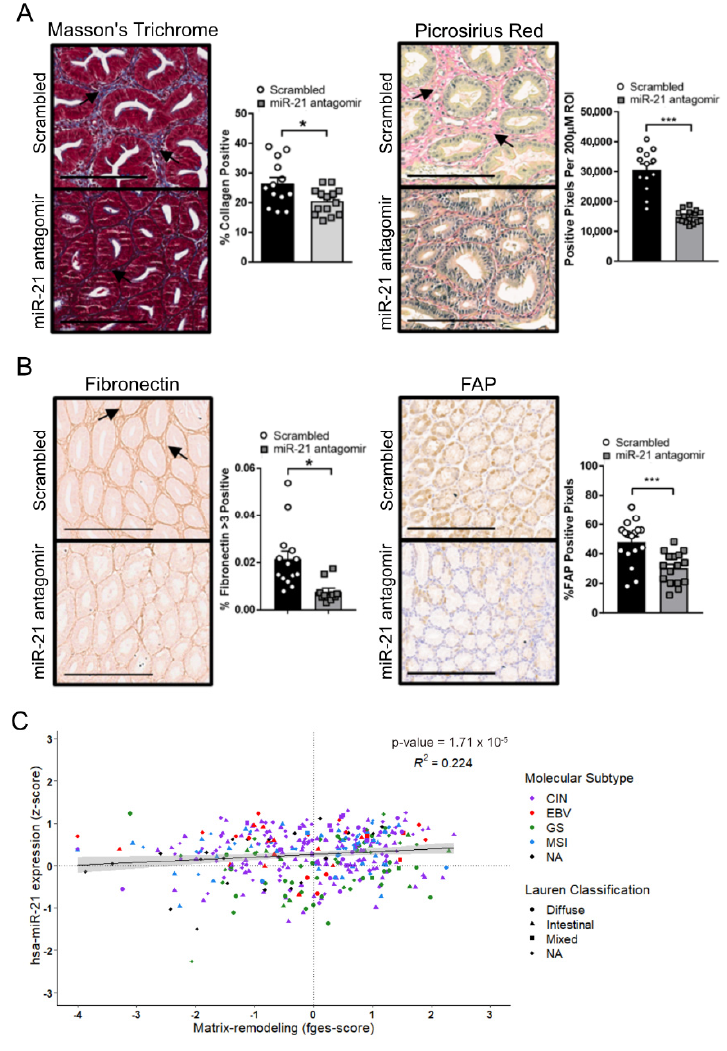
Figure 7. miR-21 promotes ECM remodeling in the tumors of Gp130 F/F mice. ( A ) Representative Masson’s trichrome and picrosirius red stains on cross-sections of adenomas collected from 12-week old Gp130 F/F mice after the end of a 4-week treatment period with the scrambled control or miR-21 antagomir. The quantification of the staining was performed by ImageScope analysis software. ( B ) Representative IHC stains for fibronectin and fibroblast-activated protein (FAP) on cross-sections of adenomas collected from 12-week old Gp130 F/F mice after the end of a 4-week treatment period with the scrambled control or miR-21 antagomir. The quantification of the staining was performed by ImageScope analysis software. ( C ) Correlation analysis of miR-21 (z-score) with the “Matrix- remodeling” functional gene signature using the TCGA STAD dataset. Each dot represents a single cancer, indicating both its molecular subtype and Lauren classification. The data are presented as the mean ± SEM, with each point representing an individual mouse. * p < 0.05; *** p < 0.001. Scale bar = 200 µm.